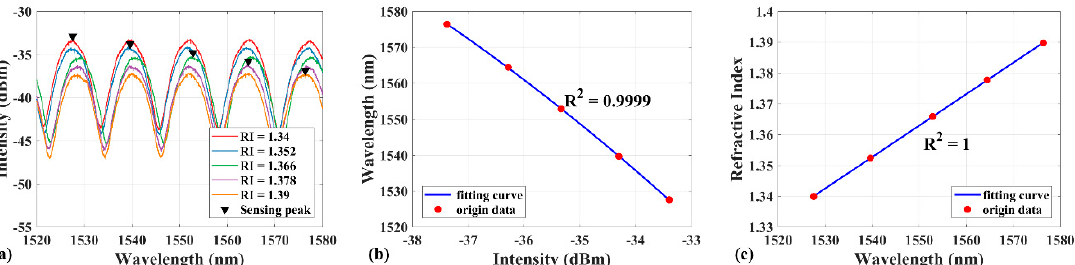
Figure 5. ( a ) The actual interference spectrum with five different RI liquids; the peaks marked with the black triangle are the actual sensing peaks with same interference order. ( b ) Location curve and ( c ) response curve of the EFPI RI sensor. The red scatter points and blue curves represent the experimental data and the fitting curves separately.